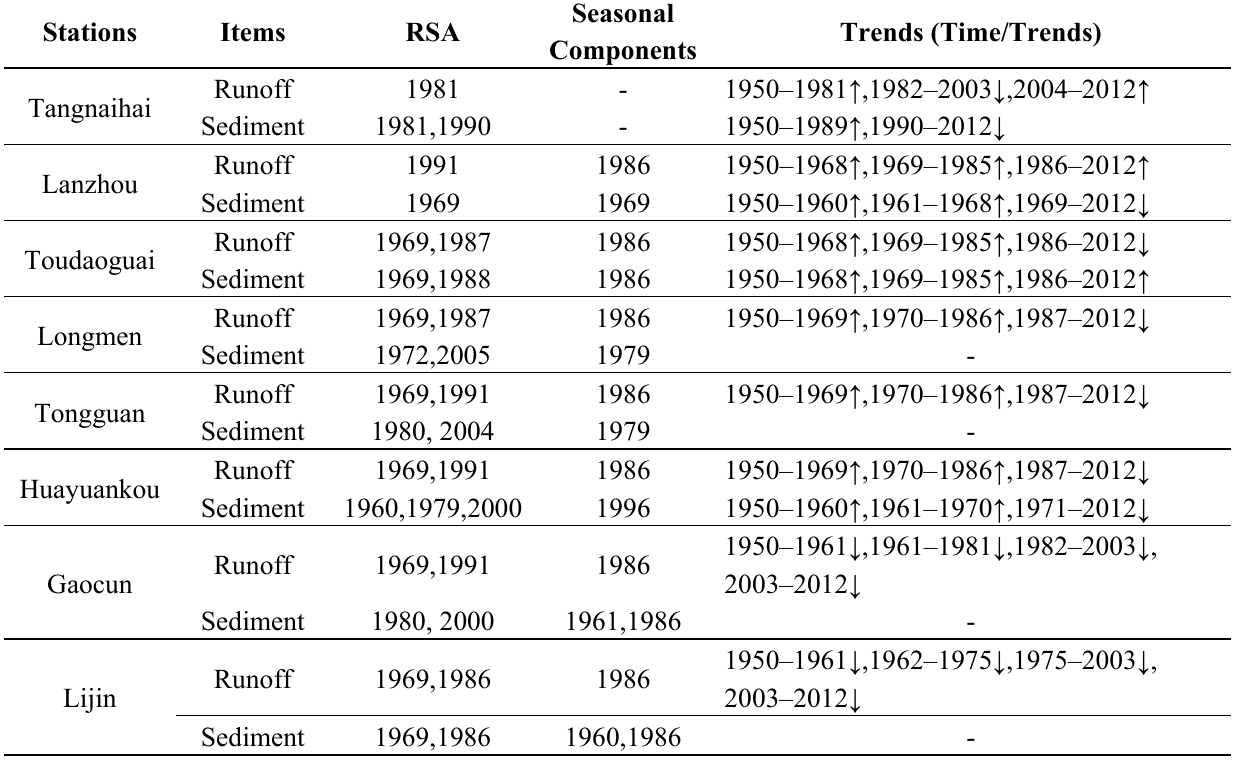
Table 2. Temporal changes in the annual runoff of the Yellow River.